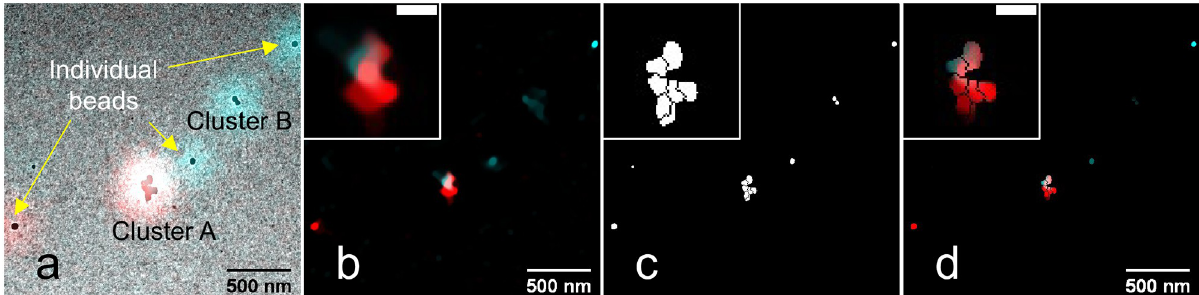
Fig 3. Overlay of CLEM images of fluorescent beads and its total variation deconvolution. a) The identification of each beads’ color is difficult in the overlay of the CLEM image. b) The result of modified total variation deconvolution after 100 iterations, at λ = 10 − 7 , ε = 10 − 10 . c) The binary mask created from the EM image with watershed segmentation. It can improve the image resolution, but is not sufficient to distinguish the colors of clustered beads. d) Multiplication of (b) and (c). Morphology is visible but colors cannot clearly be identified. We clipped values above 40% of the maximum brightness for better visualizations of small